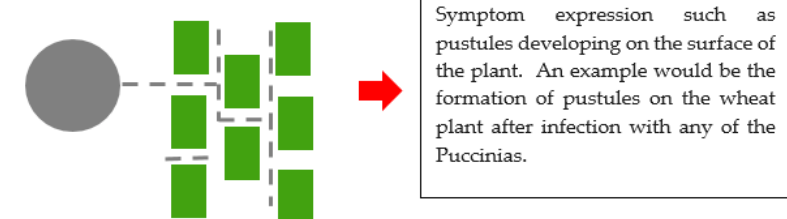
Figure 3. An illustration of biotrophy between a plant pathogenic fungus and a plant. The grey circle represents a fungal spore. Dotted lines represent the germ tube which has developed to form a network of hyphae, and the green rectangles represent plant cells. Finally, symptoms are expressed.